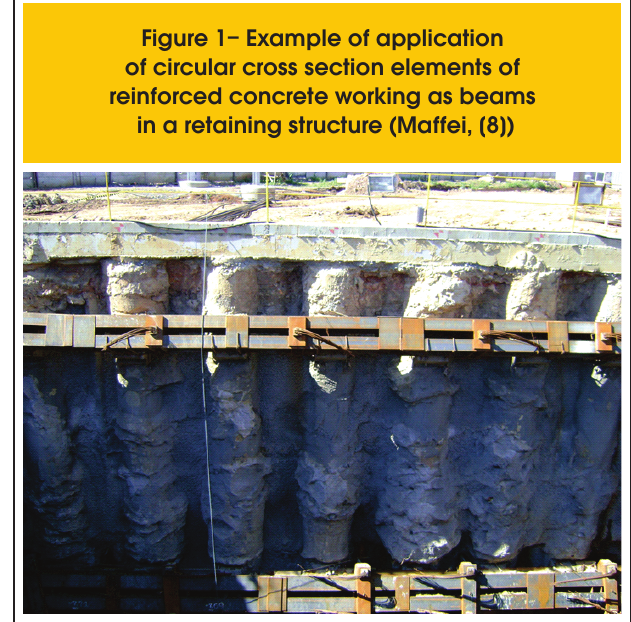
Figure 1– Example of application of circular cross section elements of reinforced concrete working as beams in a retaining structure (Maffei,